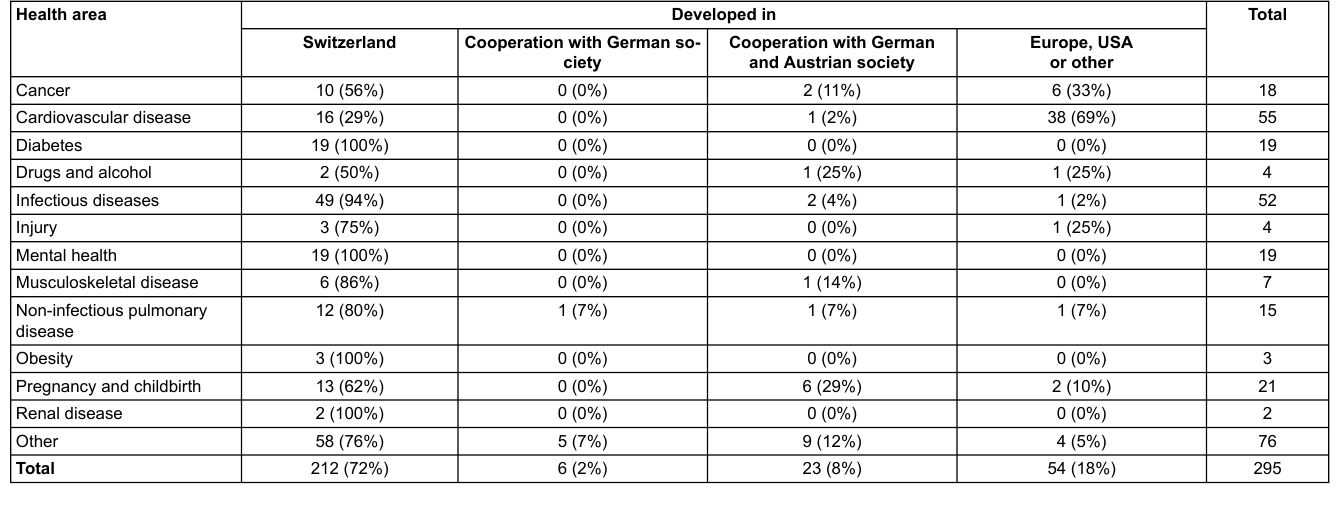
Table 1: Health area and country(ies) of origin.